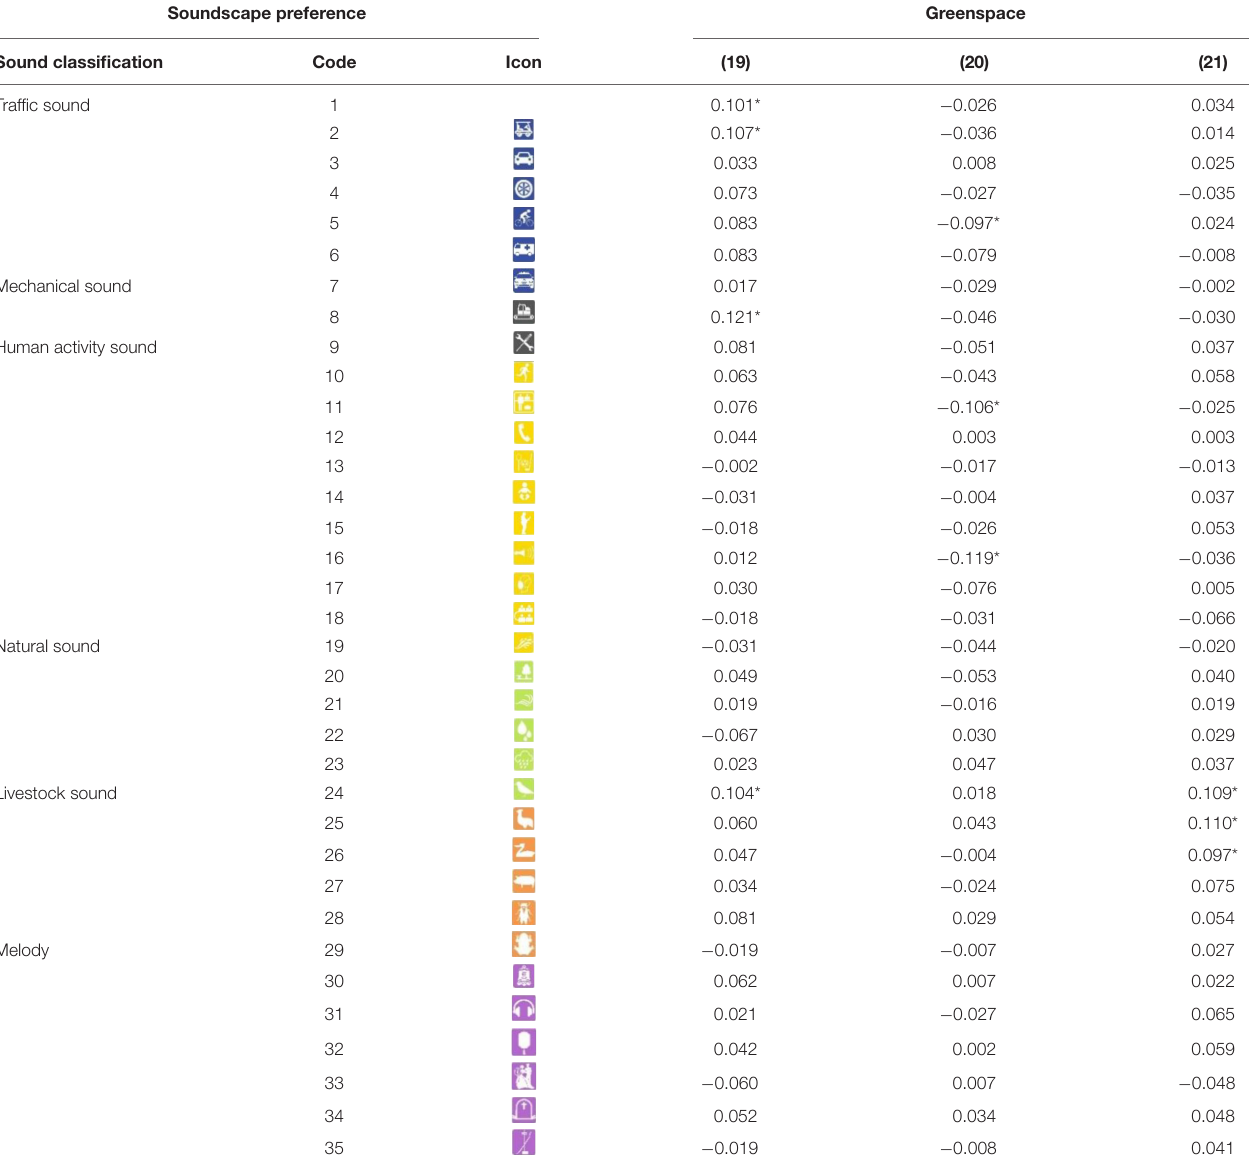
TABLE 4 | Correlation between personal living conditions and soundscape preference (code is shown in Table 1